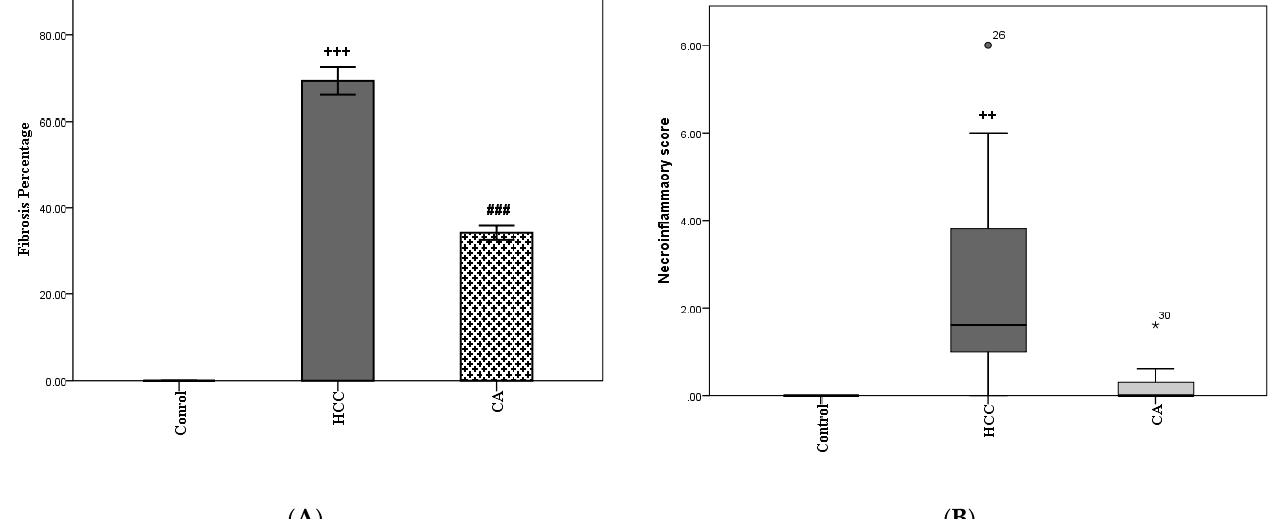
Figure 1. CA decreases in fibrosis percentage ( A ) and necroinflammatory score ( B ) in liver homogenate. Data in A were expressed as mean ± S.E.M and data in B were expressed as median and range. Ten rats in each group. ++ p < 0.01, +++ p < 0.001 vs. control group, ### p < 0.001 vs. HCC group.